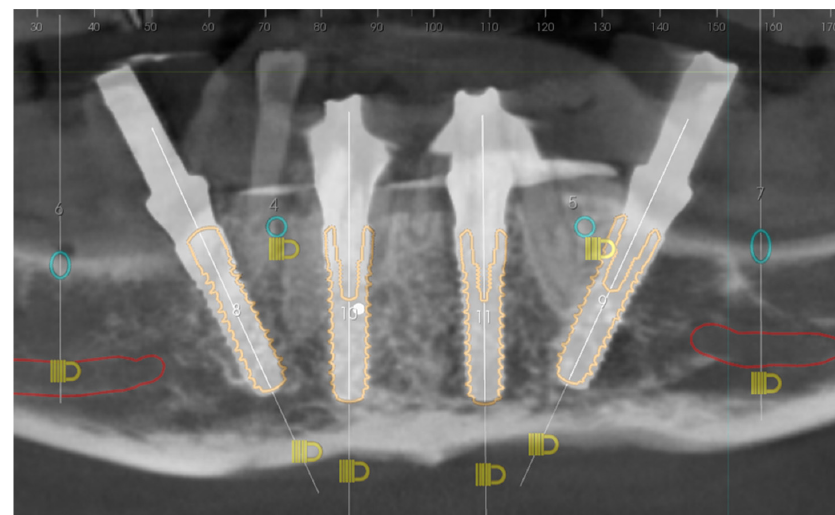
Figure 19. Comparison between digital plan and post-op results.